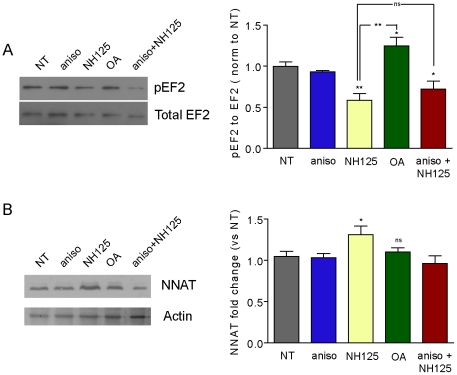
NNAT translation in synaptoneurosomes is regulated by EF2 phosphorylation.(A) SNS were treated with anisomycin (aniso), NH125 (an EF2 kinase inhibitor), 2 nM okadaic acid (OA) (an inhibitor of PP2A), or anisomycin+NH125, followed by immunoblot of phosphorylated (pEF2) and total EF2. Values were graphed as a ratio of phospho- to total EF2 and normalized to no treatment (n = 6 per group). (B) Total NNAT levels in synaptoneurosomes treated as in (A). Values were normalized to actin and compared to the no treatment group. Sample size was n = 7 (4 independent experiments) per group. ** p<0.01, * p<0.05).